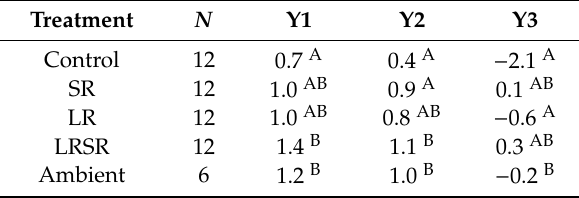
Table 3. Median mean temperature rank values (°C) for years 1–3 (Y1, Y2, Y3) for all four treatment types and ambient conditions. Values with different letter assignments within columns denotes significant differences using Tukey HSD with α ≤ 0.05.